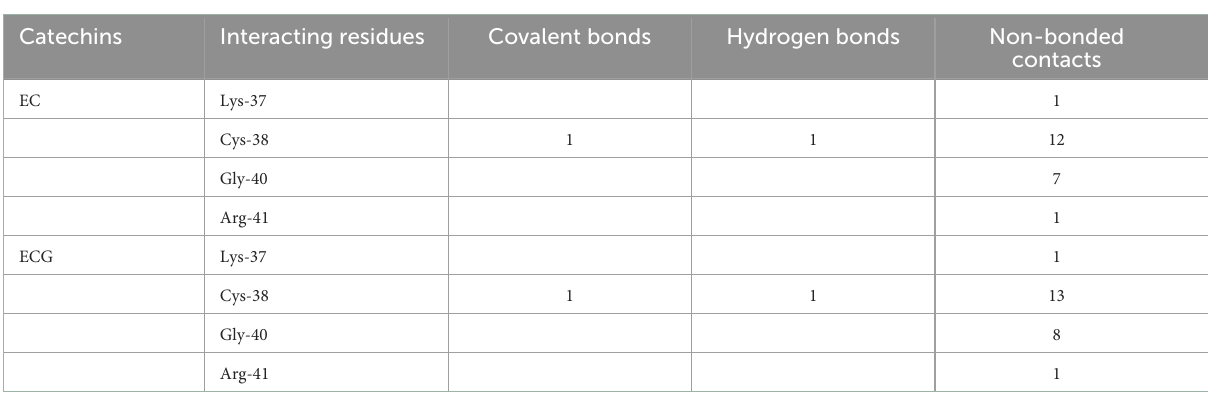
TABLE 1 Interacting residues of NF- κ B p65 for EC and